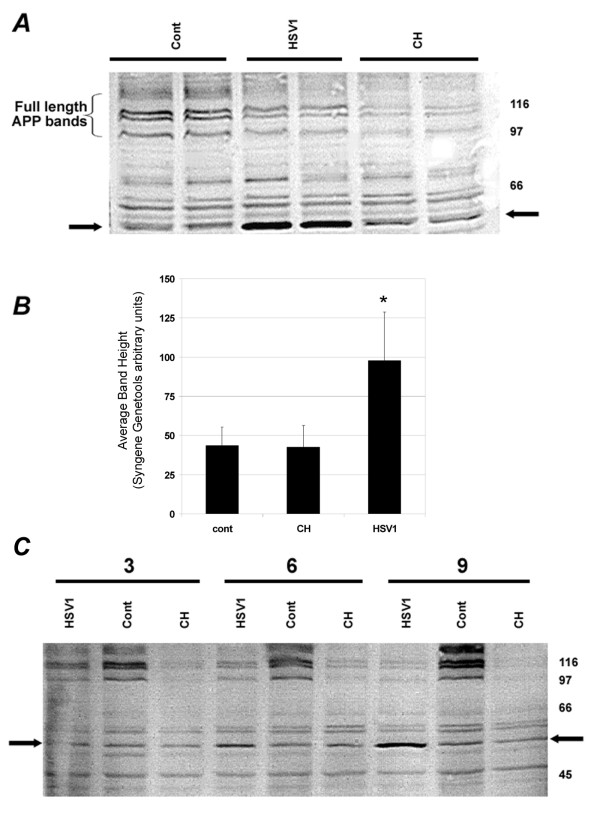
Effect of HSV1 infection on APP processing in SHSY5Y cells. (A) SHSY5Y human neuroblastoma cells were either untreated (cont), infected with herpes simplex virus type 1 (HSV1), or treated with the protein synthesis inhibitor cycloheximide (CH), then incubated for a further 6 h. Cell lysates were subjected to Western blot analysis, using an anti-C-terminal APP antibody (Sigma Aldrich A8717) at 1:4000 dilution. Each lane contains cell lysate prepared from a single flask (two flasks were used per treatment). Several full-length APP bands are clearly visible. Arrows indicate the band intensified by HSV1 infection. (B) Quantification of 55 kDa band in control (cont), cycloheximide-treated (CH), or HSV1 infected cells, assessed using Syngene GeneTools software. Values show average band height from five independent experiments for cells treated for 6 h, each involving two or four separately processed flasks. Bars show standard deviation. Treatments resulting in values significantly different from control are marked * (indicates p < 0.002; ANOVA). (C) Effect of time period after inoculation with virus on height of 55 kDa band. SHSY5Y human neuroblastoma cells were either untreated (cont), infected with HSV1, or treated with cycloheximide (CH), then incubated for a further 3, 6 or 9 h. Cell lysates were analysed by Western blotting as in Fig 1A. Arrows indicate the band intensified by HSV1 infection.